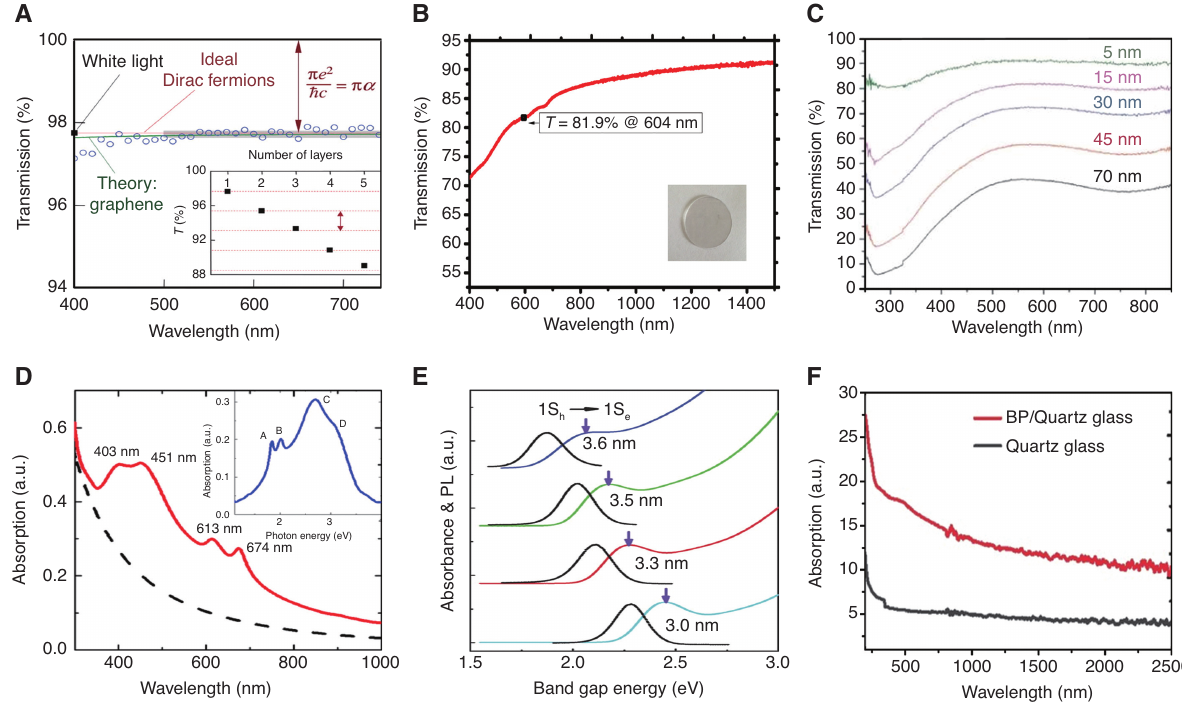
Figure 2: Representative linear optical responses of nanomaterials in visible spectral range. (A) Linear transmittance spectrum of single-layer graphene; inset: change of light transmittance versus layer of graphene. (B) Linear optical transmittance of Bi Se . (C) UV-vis spectra of Ti C T films with different thicknesses. (D) Absorption spectrum of MoS 2 3 3 2 x dashed line is the calculated scattering background); inset: absorption without the scattering. (E) Optical absorption (colored lines) and normalized photoluminescence (PL; black lines) spectra of CdTe/CdS QDs. (F) Linear absorption spectrum of the BP sample and substrate. (A) Adapted from Ref. [128], Copyright 2008, American Association for the Advancement of Science. (B) Adapted from Ref. [129],